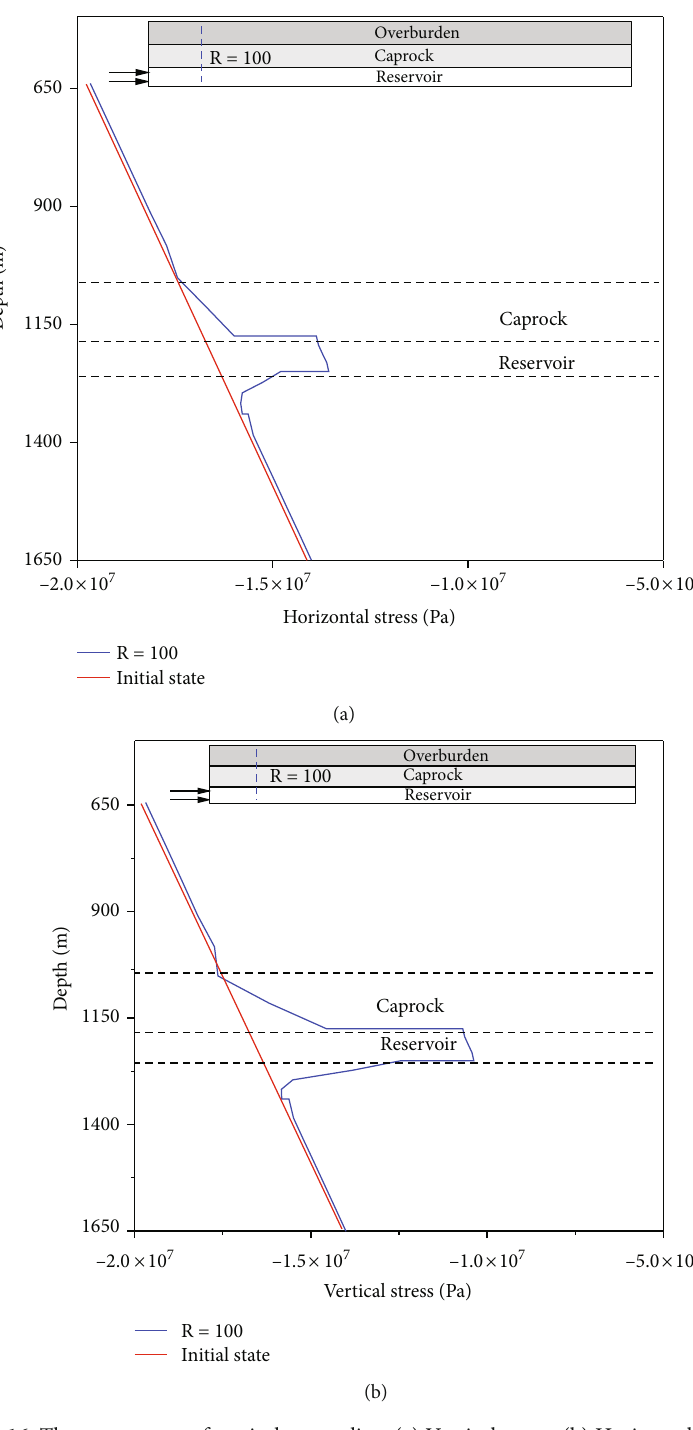
Figure 16: The stress curve of vertical survey line. (a) Vertical stress. (b) Horizontal